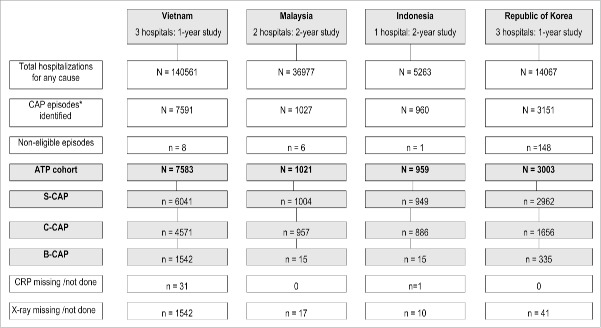
Total hospitalizations and CAP episodes in children <5 years of age, according to enrolled country. * Defined as any child aged <5 years hospitalized with any ICD-10 discharge code of interest. CAP, community acquired pneumonia; ATP, according to protocol; S-CAP, suspected CAP; C-CAP, confirmed CAP; B-CAP, bacterial CAP; CRP, C-reactive protein.